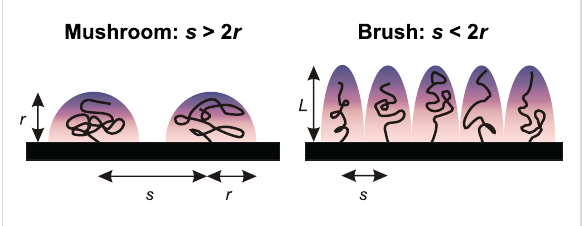
Figure 8: Mushrooms versus Polymer Brushes: a sketch illustrating how surface-tethered polymer chains can take on either “mushroom” -like or “brush”-like molecular conformations, depending on how closely packed the polymer chains are. The mushroom regime occurs when the distance between neighboring chains s , is greater than twice the radius of the polymer. The brush regime is encountered when s < 2 r and the polymer chains are extended away from the surface at a height of L . The shaded areas emphasize the stochastic nature of the polymer chains where each chain has a high probability to occupy all positions within a given